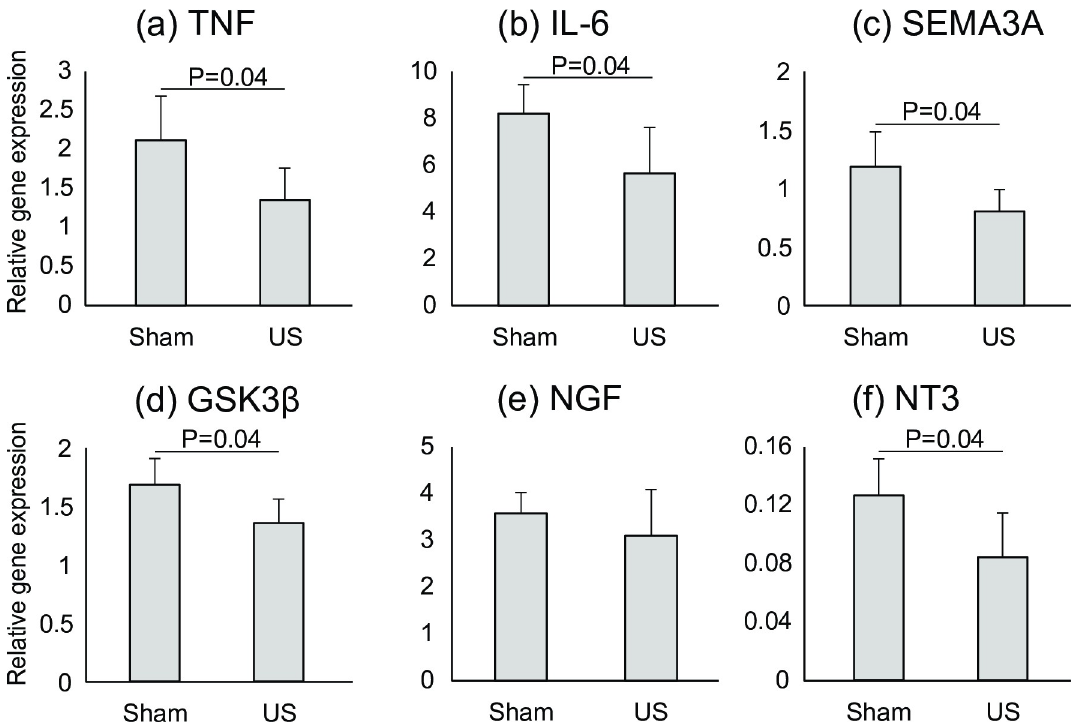
Fig 5. Gene expression analysis at 1 week after injury. Gene expression of (a) TNF, (b) IL-6, (c) SEMA3A, (d) GSK3 β , (e) NGF, and (f) NT3 in the sham (0 mW/cm 2 ) and US (140 mW/cm 2 ) groups 1 week after injury. All data are presented as means ± SD (n = 5). The value of the calibration sample (intact nerve specimen) was set to